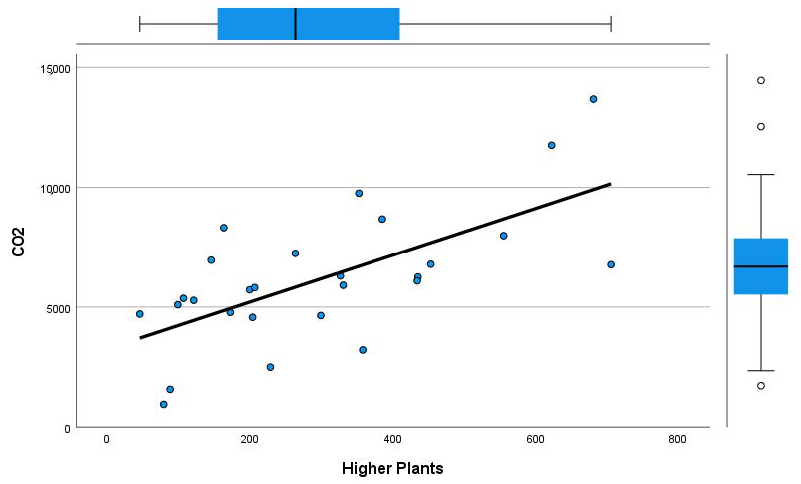
Figure 5. Regression—CO 2 fixation dependent on the phytomass of the higher plants from the 27 samples. All numbers are in grams.